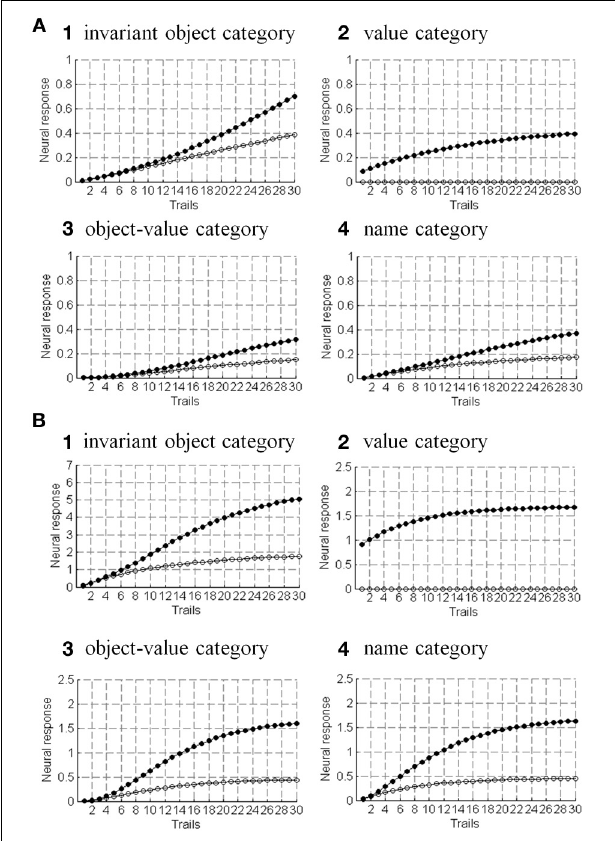
FIGURE 11 | (A) Trial-by-trial category activities during view-invariant object category learning. Category learning activities are shown both without (open circles) and with (solid circles) simultaneous reinforcement learning. Each condition involves 30 trials with each trial processing a simulated scene with an average duration of 4.05s, corresponding to Figures 8B , 10 . Data points represent the average activity levels during cellphone learning. Other objects generate similar learning curves. (1) Average view-invariant object category responses. (2) Average value category responses. (3) Average object-value category responses. (4) Average name category responses. (B) Trial-by-trial changes in positional- and view-invariant object category learning. Each trial processes three consecutive simulated scenes, each with an average duration of 3.95s, corresponding to Figures 8E–G , 12 . The curves are analogous to those in (A)